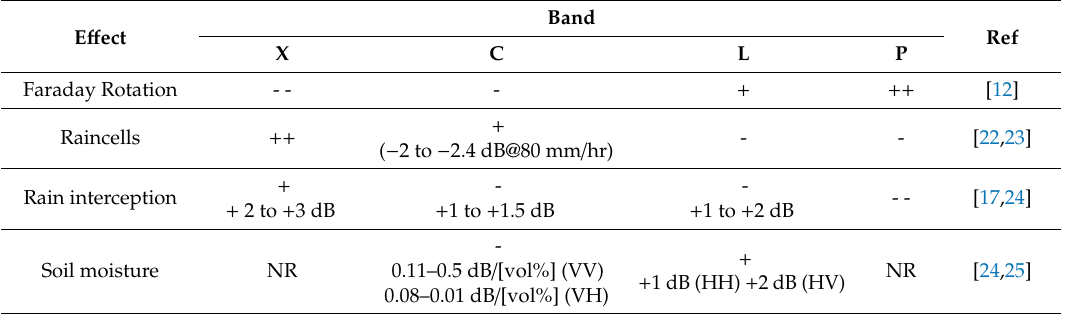
Table 1. Summary of the most important sources of errors and ambiguity in Synthetic Aperture Radar (SAR) measurements over forested surfaces found in the